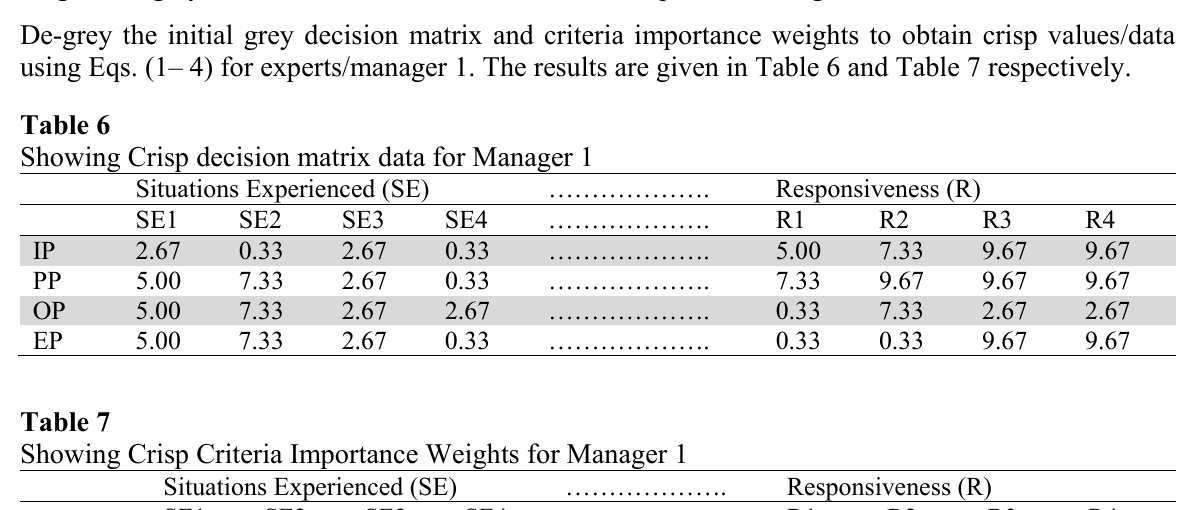
Stage 5: Normalized aggregated decision matrix and criteria importance weights All managers’ decision matrices were aggregated using Eq. (5) and then normalized using Eq. (7). Table 8 shows the normalized aggregated decision matrix for all